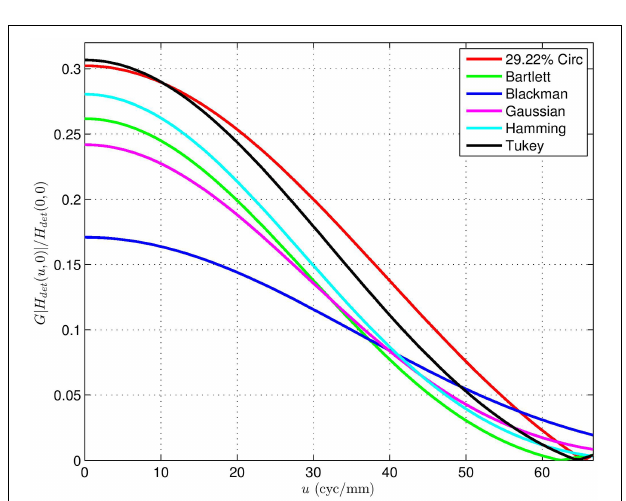
FIGURE 19 | Detector magnitude frequency response of circularly symmetric versions of the active areas in Figure 17 scaled relative to the DC gain of a 100% fill factor